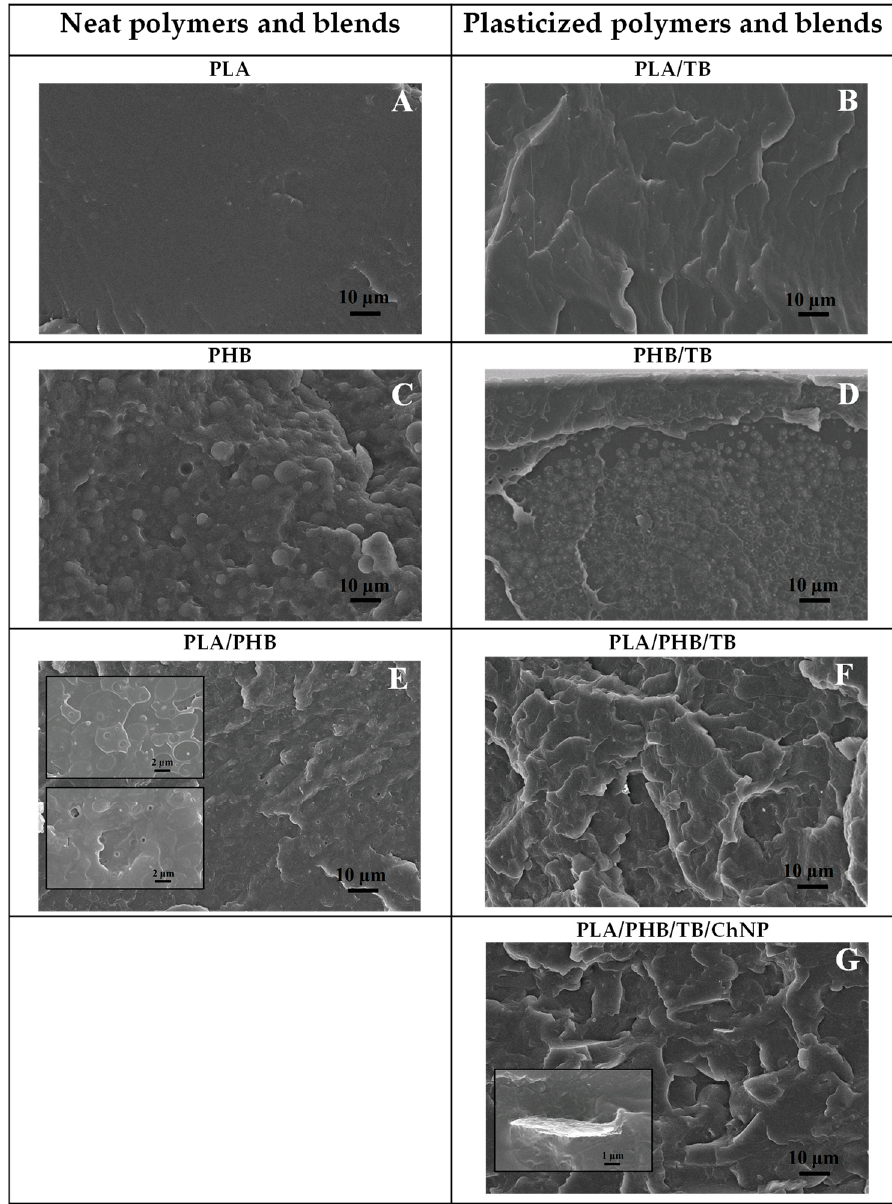
Figure 4. SEM micrographs of fracture surface of ( A ) PLA, ( B ) PLA/TB, ( C ) PHB, ( D ) PHB/TB, ( E ) PLA/PHB, ( F ) PLA/PHB/TB, and ( G ) PLA/PHB/TB/ChNP.